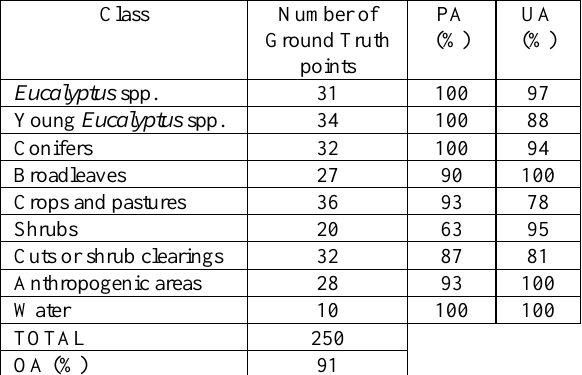
Table 4. Cross verification results obtained for the general classification. GT: Ground Truth. UA: User’s Accuracy in